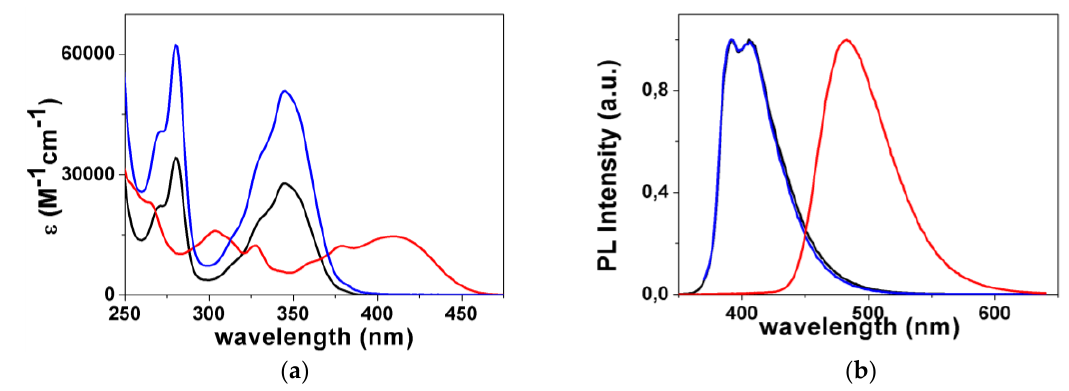
Figure 2. ( a ) Absorption spectra in CHCl 3 solution of L 1 (black line), [L 1 H] + (red line), and ZnL 1 (blue line); ( b ) Emission spectra in CHCl 3 solution of L 1 (black line), [L 1 H] + (red line), and ZnL 1 (blue line).